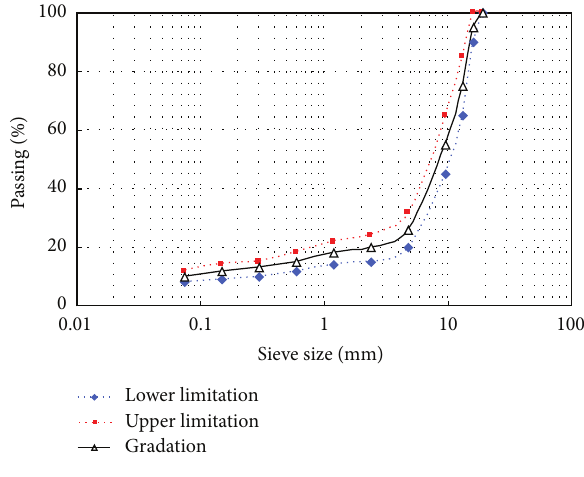
Figure 1: Grading curve of SMA-16.